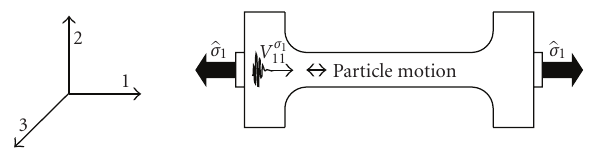
Figure 1: Ultrasonic wave propagation in the direction of loading in a uniaxially loaded column. If the constituent material is nonlinear, the propagation wave velocity V σ 1 11 is stress